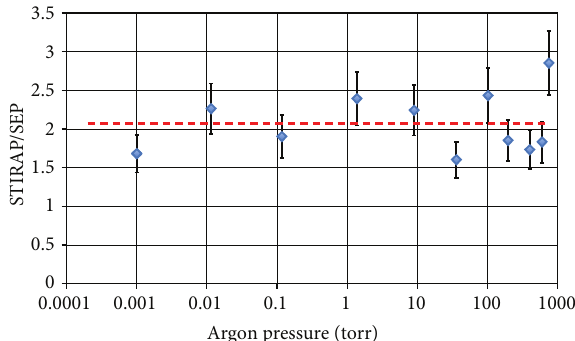
Figure 9: STIRAP/SEP ratio of sodium vapor as a function of argon buffer gas